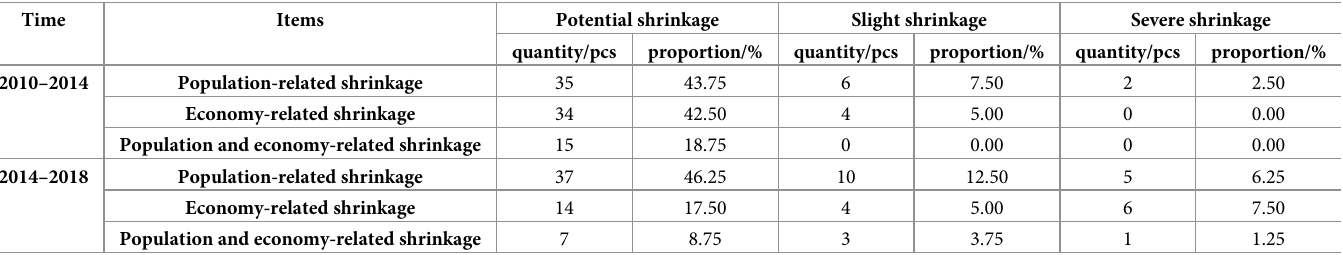
Table 4. Hierarchical statistics of shrinking cities in the Yellow River Basin in 2010–2014 and